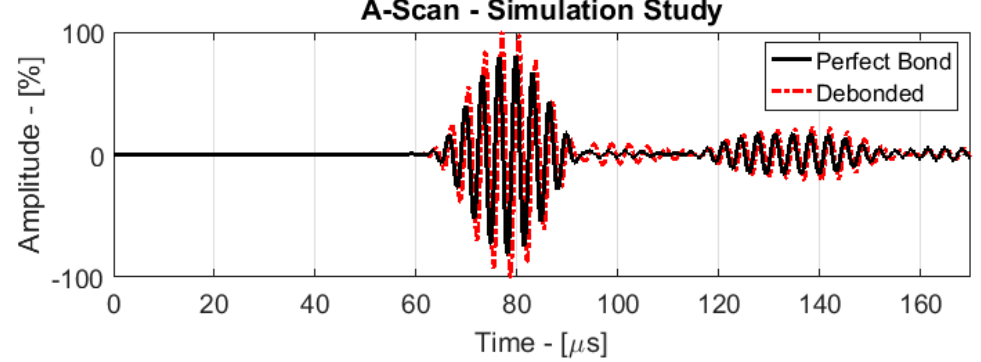
Figure 17. Guided wave A-scan—numerically simulated with probe point across the bond.